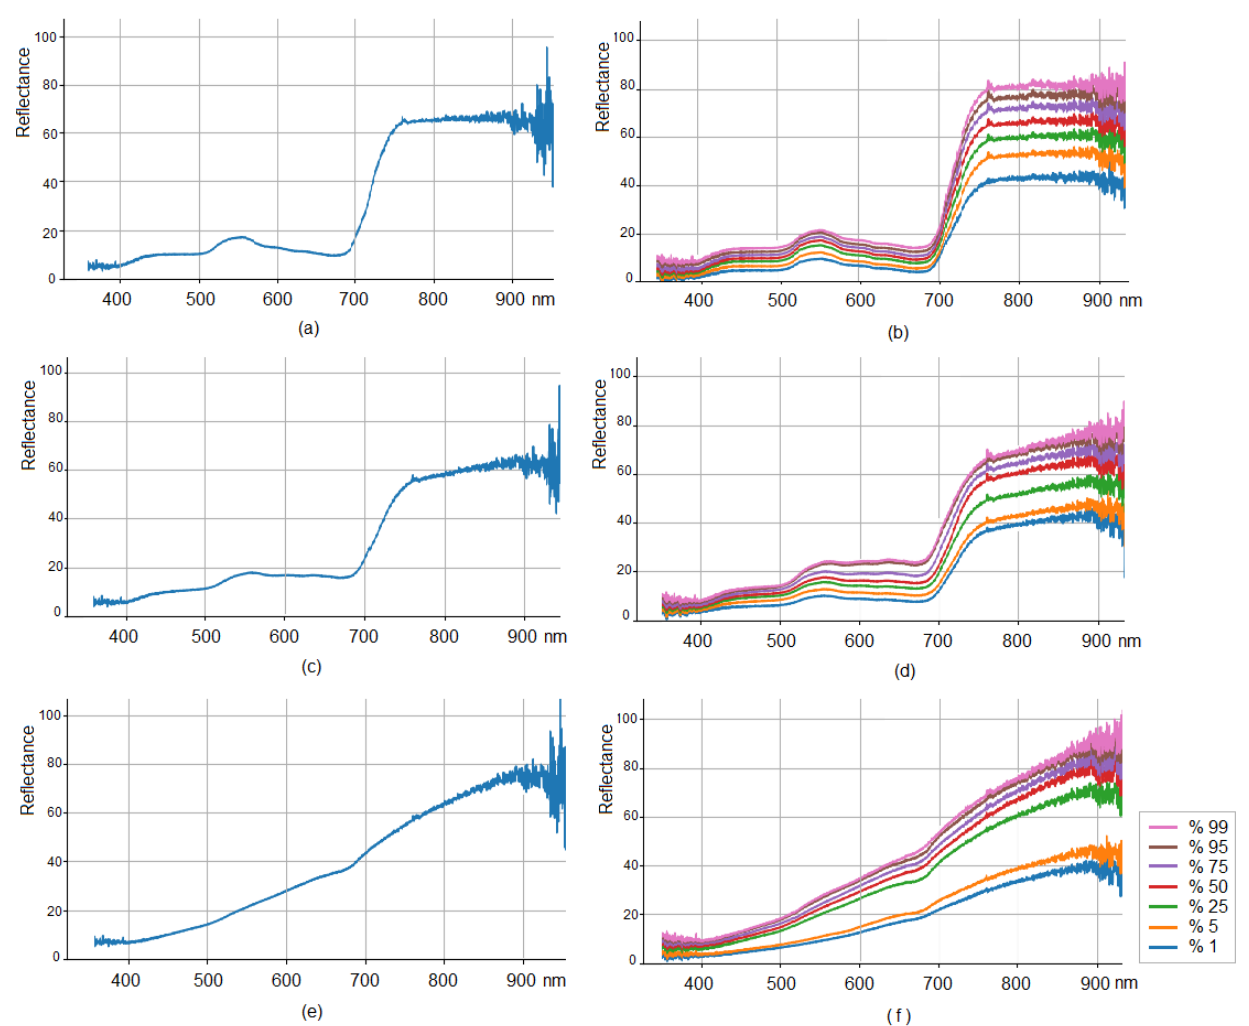
Figure 5. Datasets of means and quantiles of variety of hyperspectral curves of leaves: ( a , c , e )—means of healthy, medium-damaged and severely damaged leaves, respectively; ( b , d , f ) quantile distribution of the same datasets.